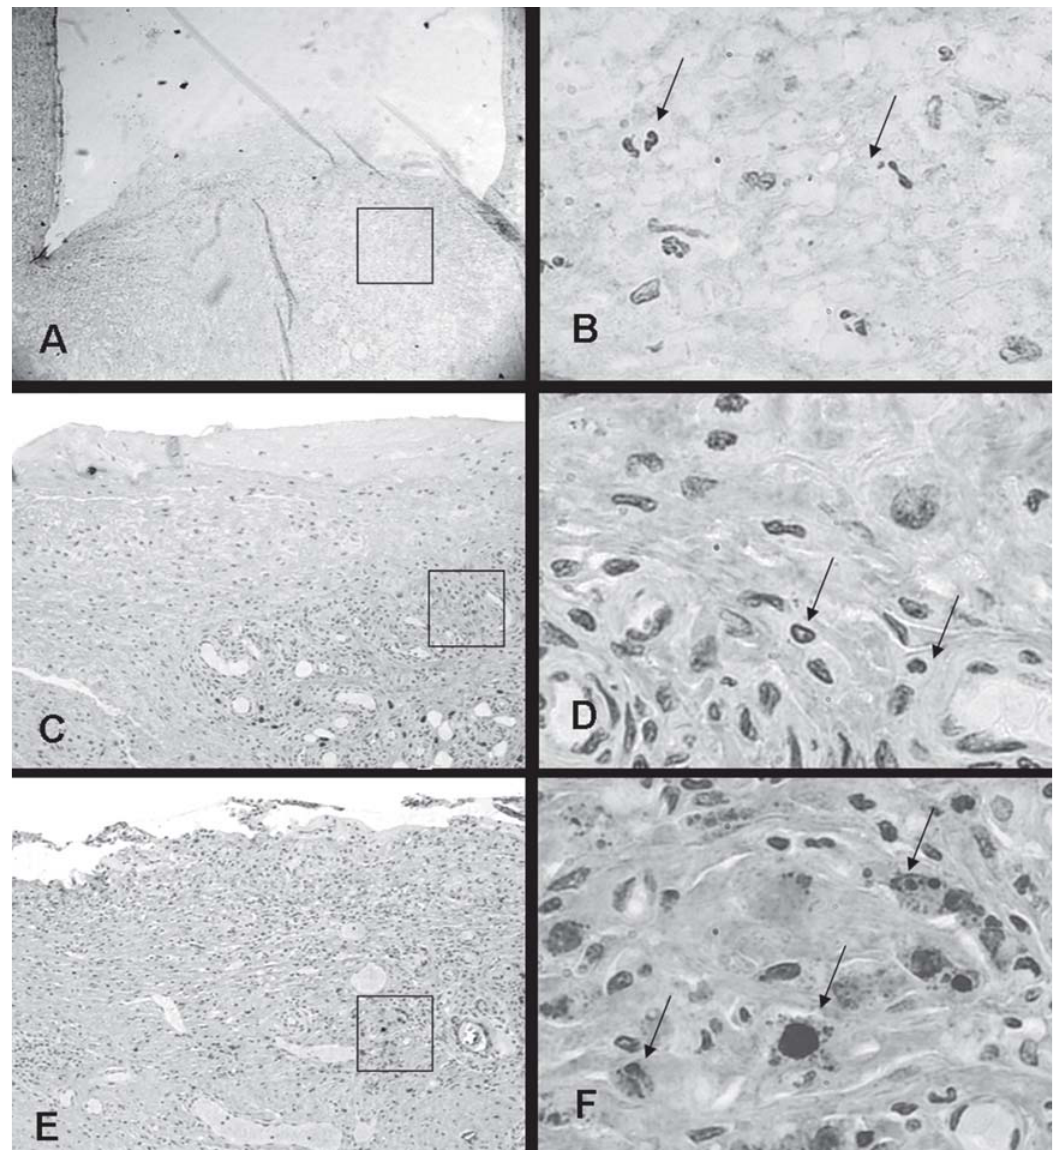
FIGURE 1- Rat subcutaneous tissue reaction to Endométhasone. The tissue on the tube end is disorganized and infiltrated with neutrophils on the 3rd day - HE 50x (A). Greater magnification showing neutrophils (arrows) and absence of collagen fibers between the cells - HE 400x (B). On the 7th, day the tissue presented more organized with the presence of chronic cells - HE 50x (C). Greater magnification showing chronic cells (Arrows) - HE 400x (D). Milder reaction on the 30th day, with the presence of an organizing fibrous capsule - HE 50x (E). Greater magnification showing chronic cells (arrows) and collagen fibers between the cells - HE 400x